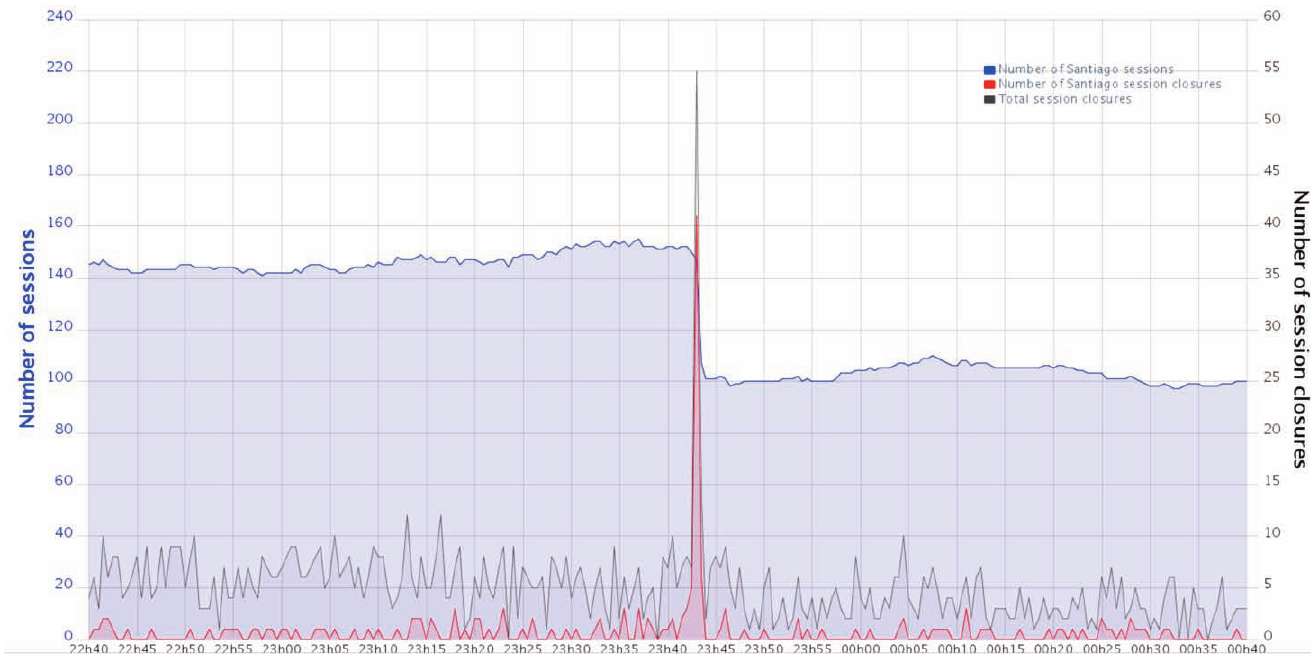
Figure 7. Example of tweets published by the EMSC under the username @LastQuake for the M 5.8 earthquake in western Turkey on May 19, 2011. The first tweet (bottom) was automatically published once the website traffic surge was detected 3 min and 25 s after the earthquake occurrence. The origin of the website visitors identified western Turkey as the area where the shock had been felt. The first location and magnitude were published 6 min and 44 s after the earthquake, with a preliminary magnitude of M 5.9. This triggered the publication of the second tweet (top). The same information is published in a scrolling banner at the same time on the EMSC website, pointed to by the shortened URL in the tweet. In the first tweet, the 2 min is estimated from the previous trigger, which had a median time of 88 s (Figure